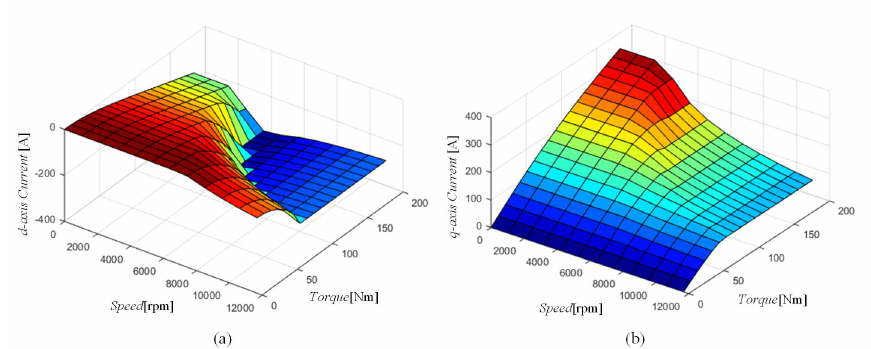
Figure 6. Proposed d -/ q -axis currents map: ( a ) d -axis and ( b ) q -axis.